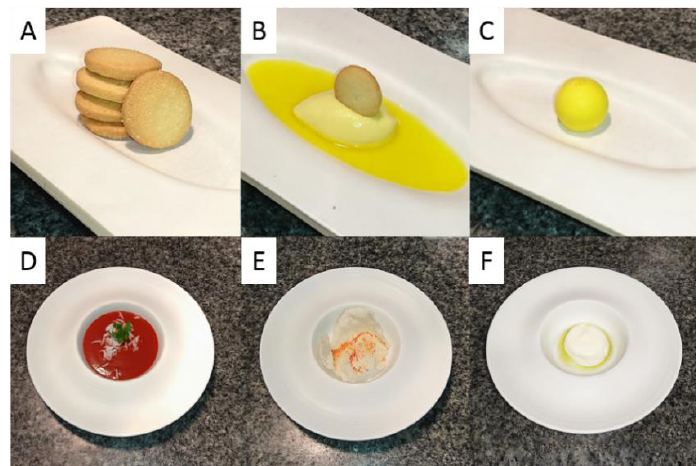
Figure 1. Plating proposition of: ( A ) lemon cookie, ( B ) molecular “lemon cookie”, ( C ) Note by Note “lemon cookie”, ( D ) traditional tomato soup, ( E ) molecular “tomato soup’, ( F ) Note by Note ‘tomato soup”.